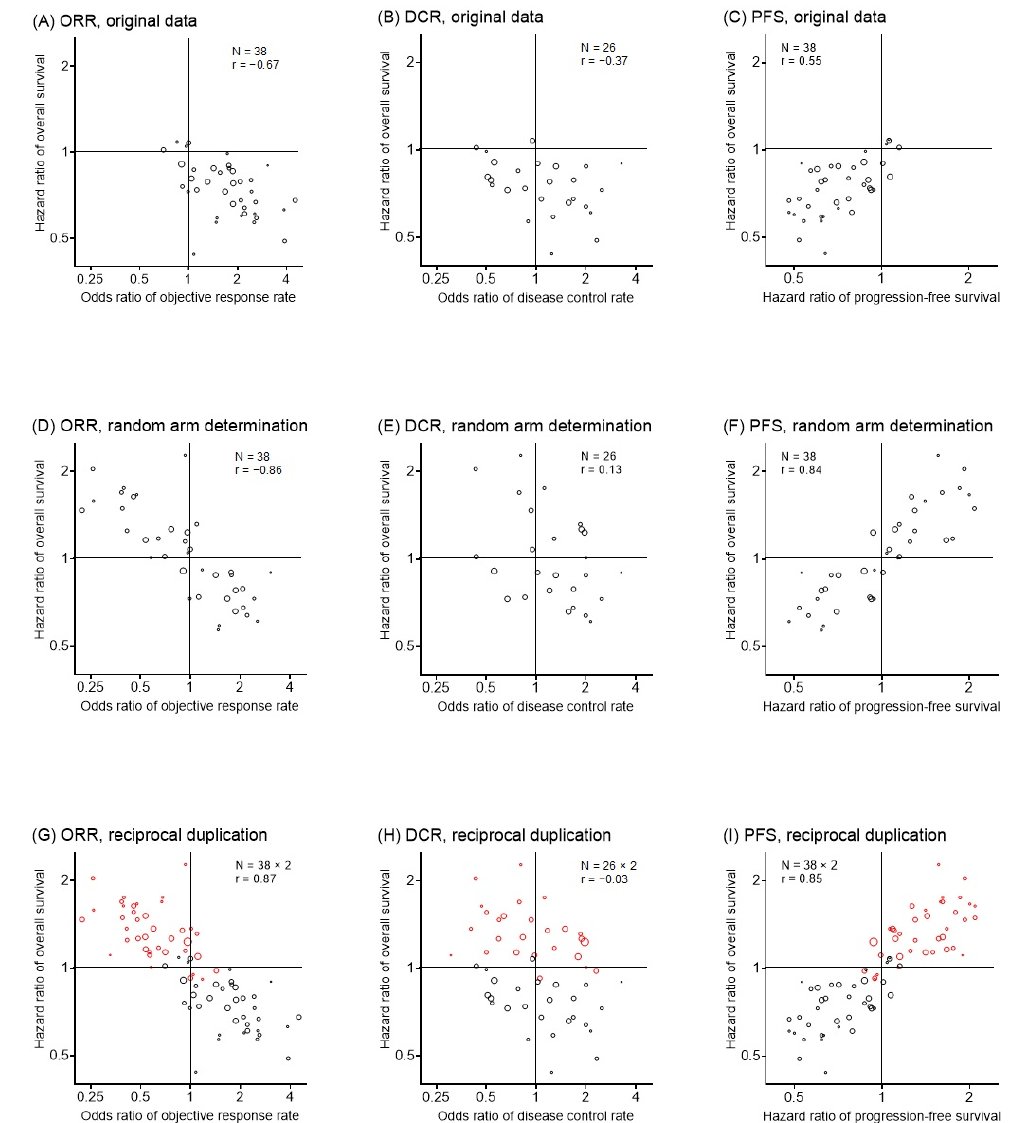
Figure 2. Study-level correlation. Each circle represents one randomized trial. Circle size represents study weight. Red circles indicate the point-symmetry of the original samples (black circles) to produce reciprocal duplication. N , number of trials; r, weighted rank correlation coefficient. ORR, objective response rate; DCR, disease control rate; PFS, progression-free survival. ORorr ( N = 38, r = − 0.67), ORdcr ( N = 26, r = − 0.37), and HRpfs ( N = 38, r = 0.55) were found to be meaningfully correlated with HRos (Figure